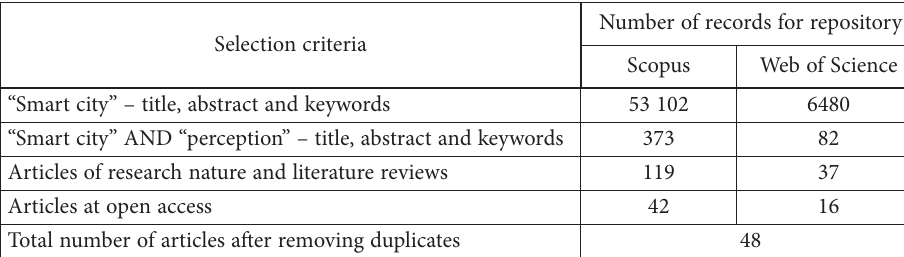
Table 1. Literature review for selected frases (source: created by authors)